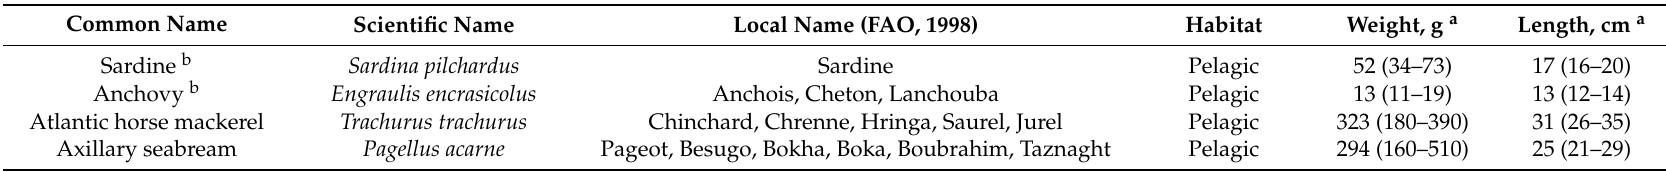
Table 2. Species, habitat, weight, and length of fish sampled on the EAF Dr. Fridtjof Nansen cruise from Tangier to Cap Bojador in May 2017.